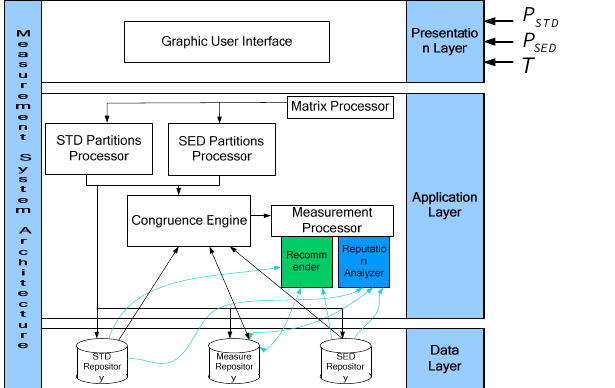
Fig.1 Measurement System